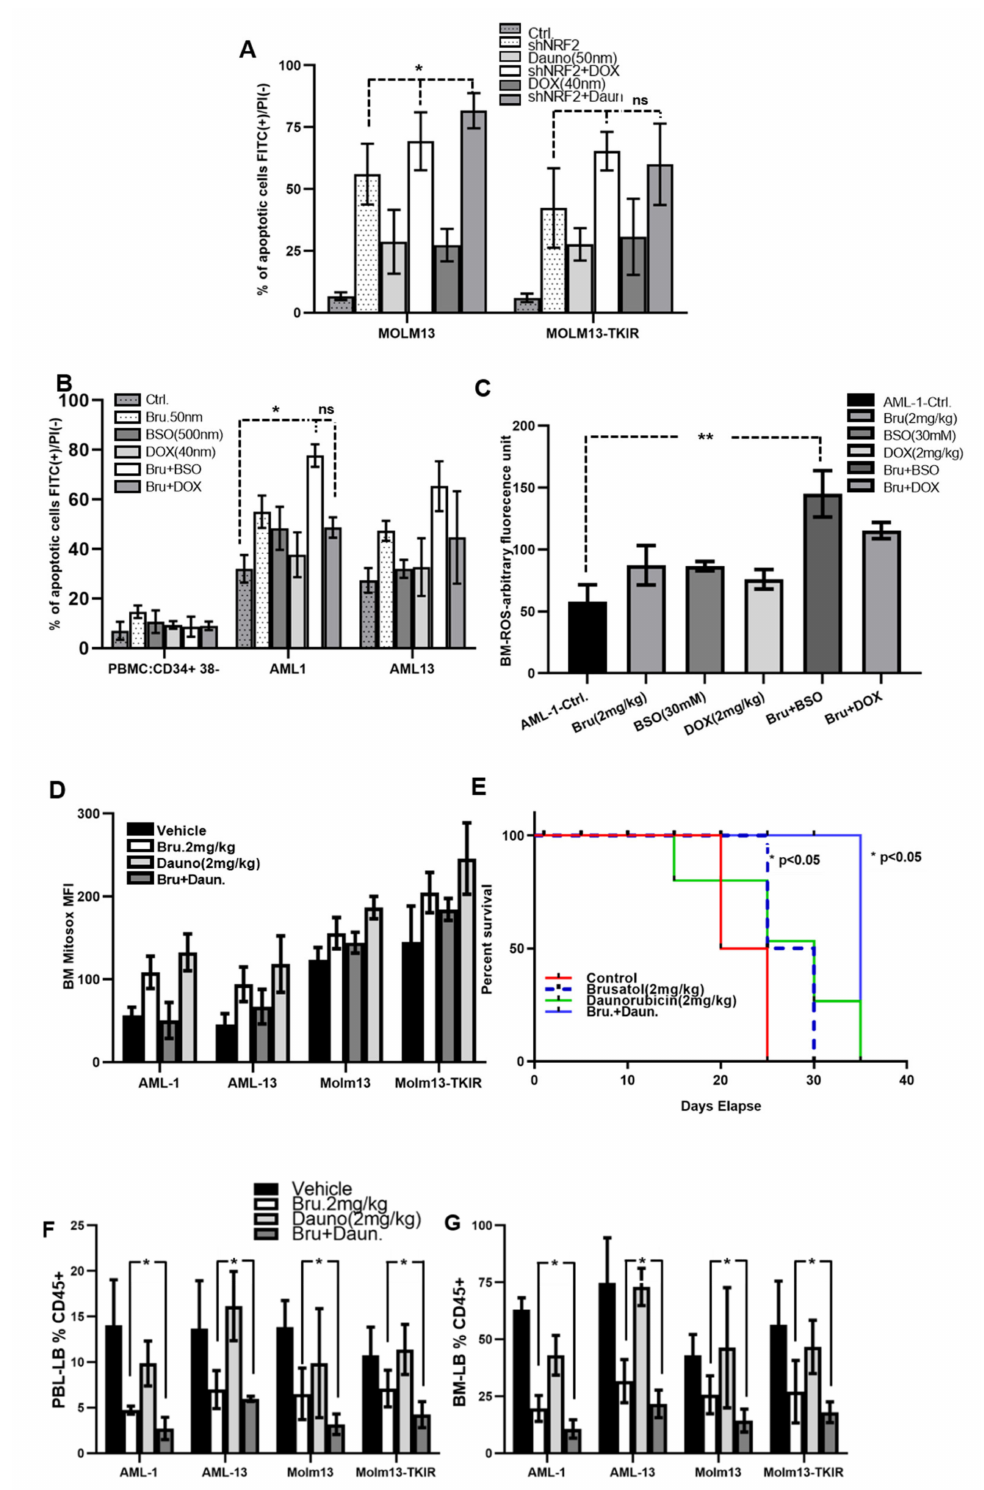
Figure 6. Pharmacologic inhibition of NRF2 potentiates chemotherapy mediated anti-leukemia activity in AML. ( A ) MOLM13 and MOLM13-TKIR cells were used for shNRF2 knockdown, treated with standard chemotherapy combination for 48 h in vitro, annexin-V FITC with PI staining was used for flow cytometry analysis. ( B ) Normal PBMC and primary AML samples treated with brusatol, BSO, DOX and their combinations for 48 h, annexin-V FITC with PI staining was used for flow cytometry analysis ex vivo. ( C ) ROS (total-cellular) levels in BM from AML-1-PDX was measured after targeted antioxidant inhibition using BSO, and brusatol, and chemotherapy treatment